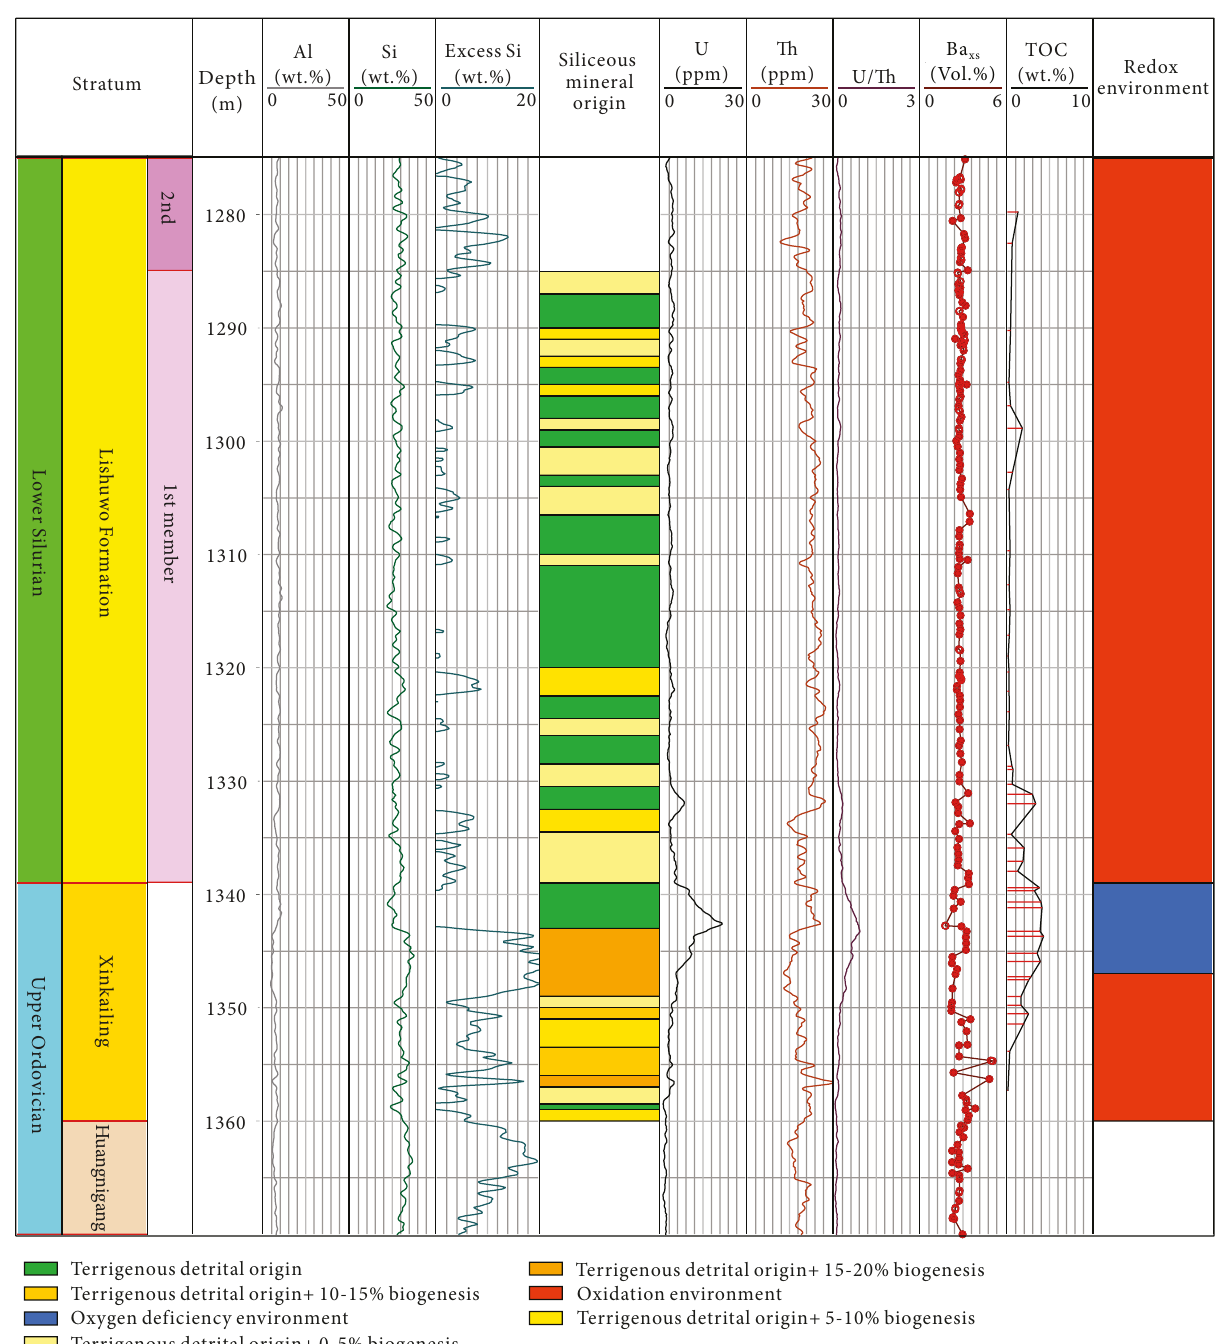
Figure 6: Excess silicon content, redox environment characteristics, paleoproductivity ( Ba Xinkailing Formation-lower Silurian no. 1 member of the Lishuwo Formation from the Y-1 well in the lower Yangtze region. The fi gure is modi fi ed from Zhang et al. [14]. See Figure 1 for the well